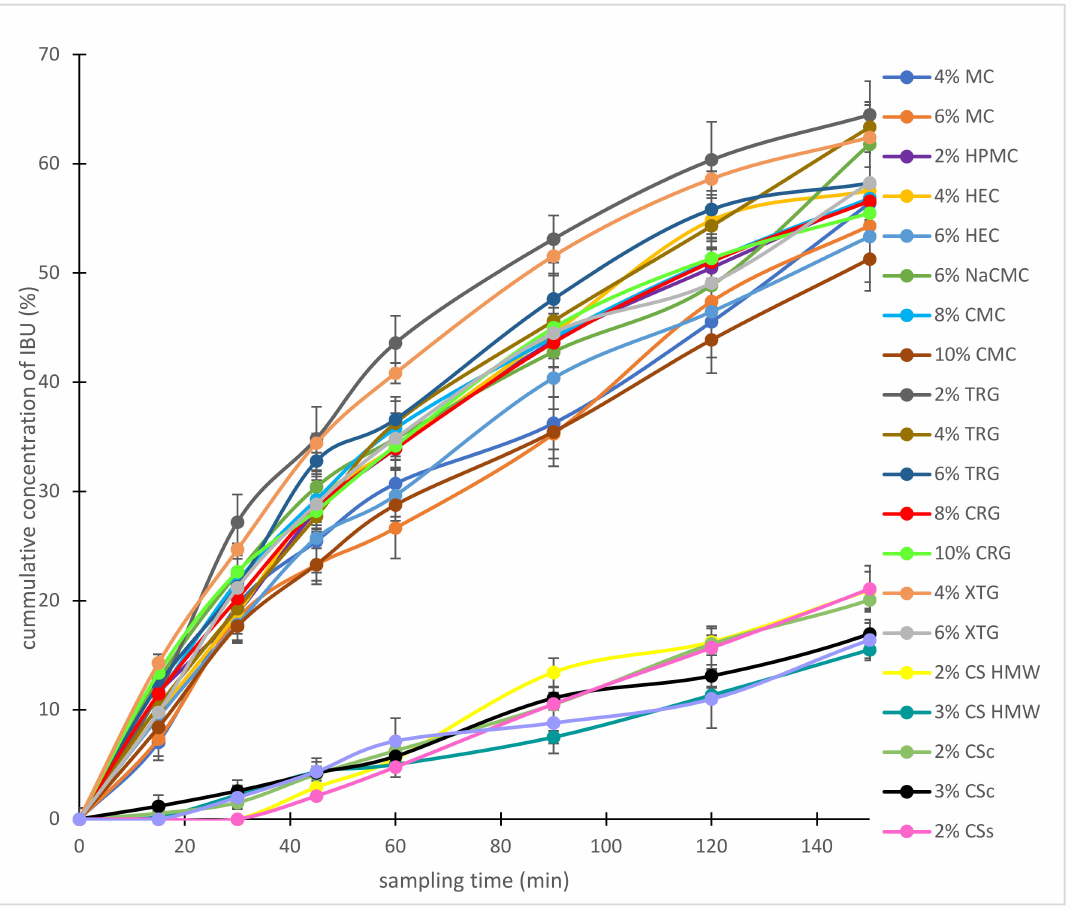
Figure 5. The cumulative amount of ibuprofen released from chosen hydrogels with time. As expected, the release of IBU was faster from low concentrated hydrogels due to their lower viscosity when comparing the hydrogels based on the same polysaccharide dif- fering in concentrations. Similar results showed, e.g., cross-linked CS hydrogels containing diclofenac according to Iglesias et al. [25]. The above-mentioned data also clearly indicated more or less significant differences between the hydrogels with different polysaccharide structures. The statistical evaluation (Student’s t -test) of IBU release for particular groups of the hydrogels, charactered by their charge, is shown in Figure 6. Significant differences ( p < 0.01) in IBU diffusion were statistically confirmed between the groups of the hydrogels composed of the positively charged polysaccharides on one side and neutral (Figure 6a) or negatively charged ones (Figure 6b) on the other side. This behavior can be logically explained via stabilization of CS-IBU associates by attractive Coulomb interactions, and, thus, a slower release of IBU from the CS hydrogels. Similar to our interpretation of the effect of ionic interactions between CS and IBU, Quandil et al. [38] found that